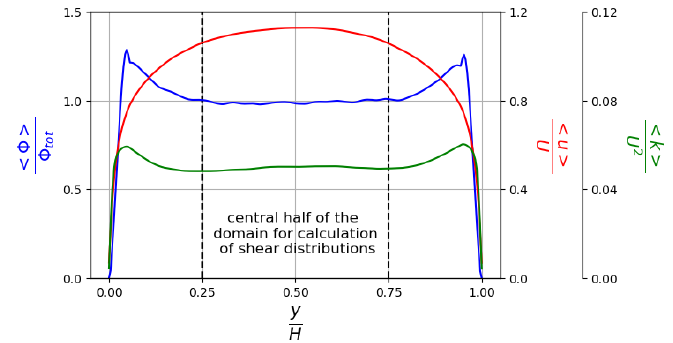
Figure 6. Illustration of the three-phase channel flow simulation. Left: Computational domain and snapshot of the solution in perspective view with two contour plots of the instantaneous vertical velocity component u in wall-normal planes close to the periodic boundaries. Right: u in a zoom of a wall-normal plane at an arbitrary position z = const. With the IBM the fluid velocity is also computed inside the bubbles. The particles shown are those in a small slab of thickness 0.025 H in z . They are drawn larger than to scale to make them visible in the plot at all.